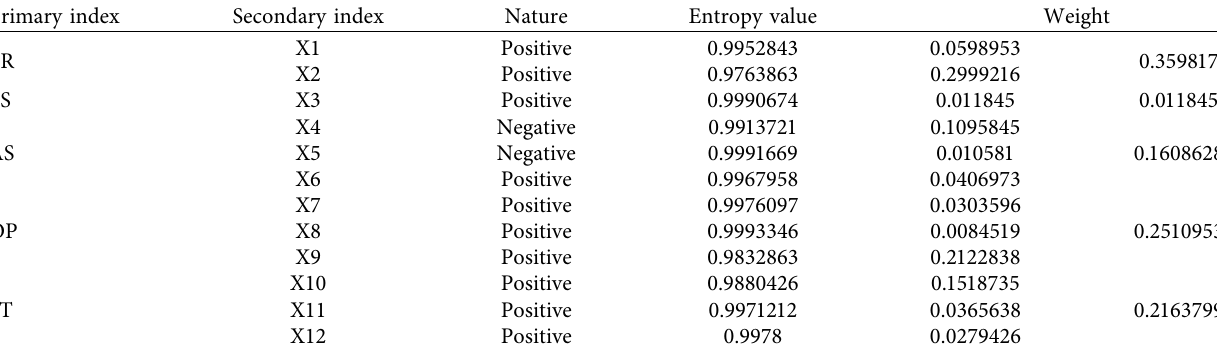
Table 2: Weights of CICQ evaluation indices.